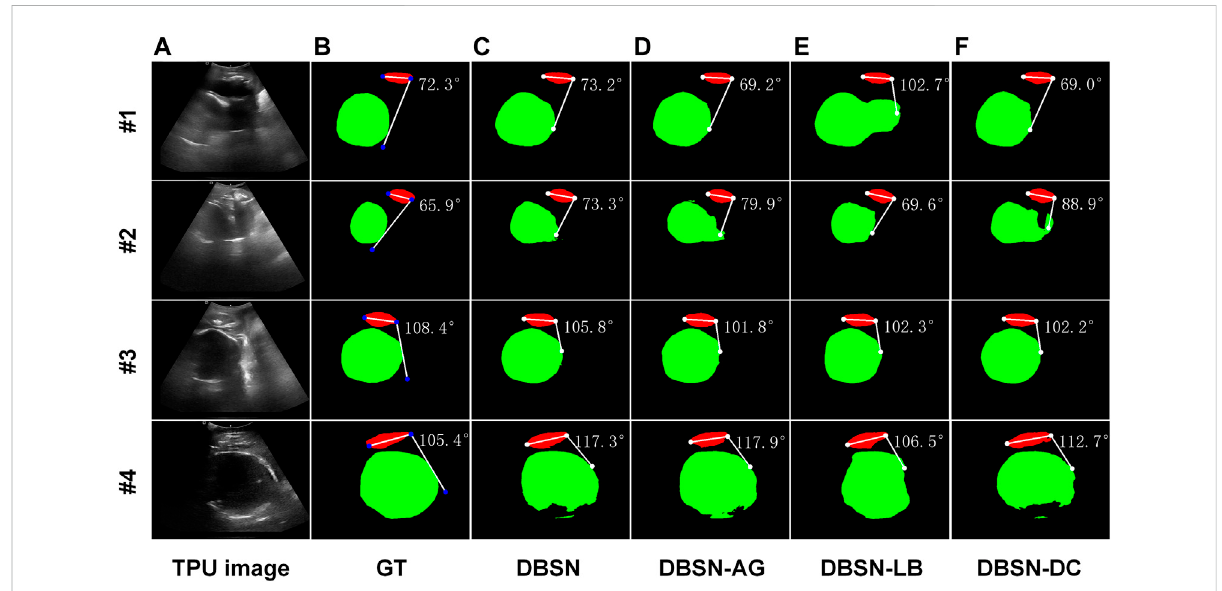
FIGURE 3 Fourexamples(#1,#2,#3and#4)ofsegmentationandAoPcalculation.Fromlefttoright,originalimagesasinput (A) ,groundtruth(GT, (B) and resultsoffourdifferentnetworksareshown.DBSN (C) ,DBSN-AG (D) ,DBSN-LB (E) andDBSN-DC (F) denotes,doublebranchsegmentationnetwork (DBSN), DBSN without the attention gate (AG), DBSN without the lower branch (LB) and DBSN without deformable convolution blocks (DC),